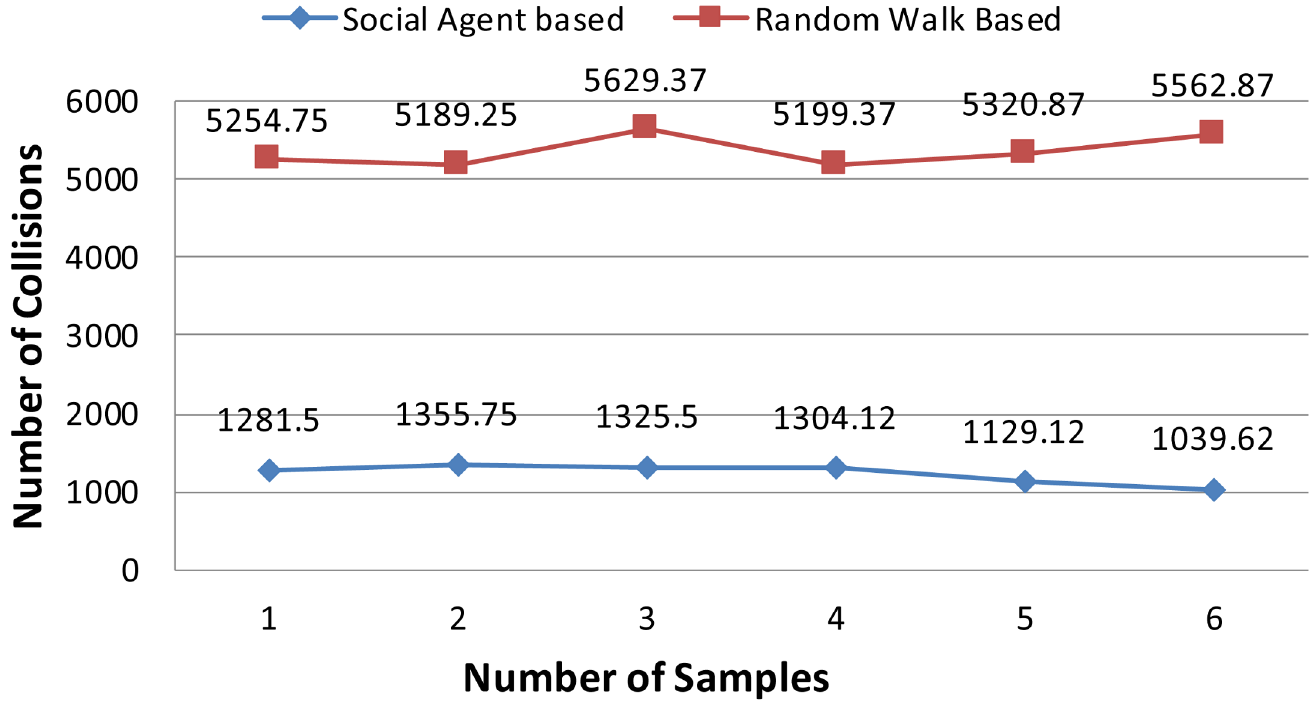
Fig 9. Graphical representation of test case